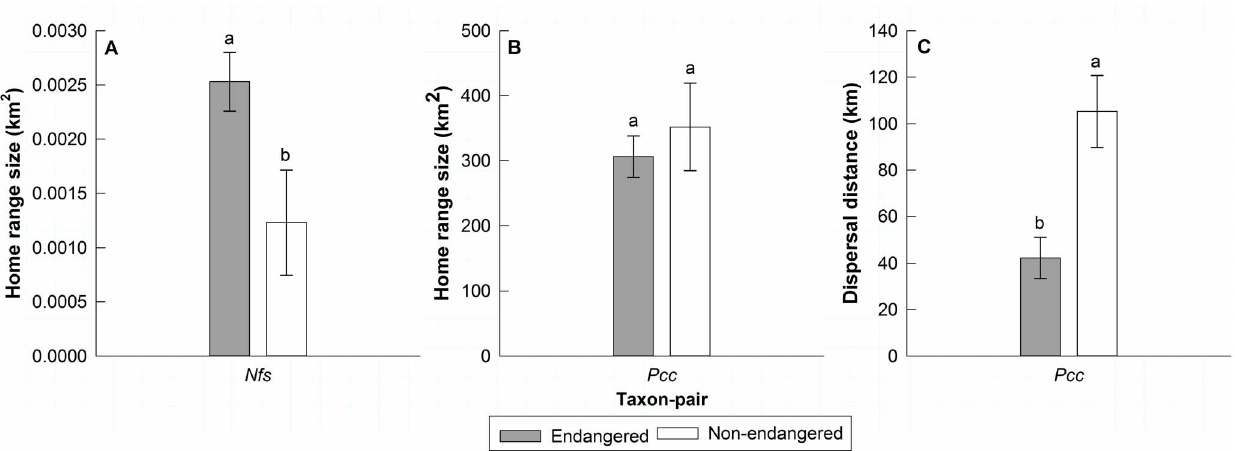
Figure 4. Home range and dispersal within taxon-pairs. Mean home range size and dispersal distance ( 6 SE) for taxon-pairs with a minimum of three independent observations per taxon. Taxon-pairs are labeled according to the federally listed subspecies. ( A ) home range for the Nfs=Neotoma floridana smalli taxon-pair, ( B ) home range and ( C ) dispersal distance for the Pcc = Puma concolor coryi taxon-pair. For each taxon-pair x trait combination, bars with different letters are significantly different (shaded bars=threatened and endangered subspecies; white bars=non- listed subspecies; p , 0.05).